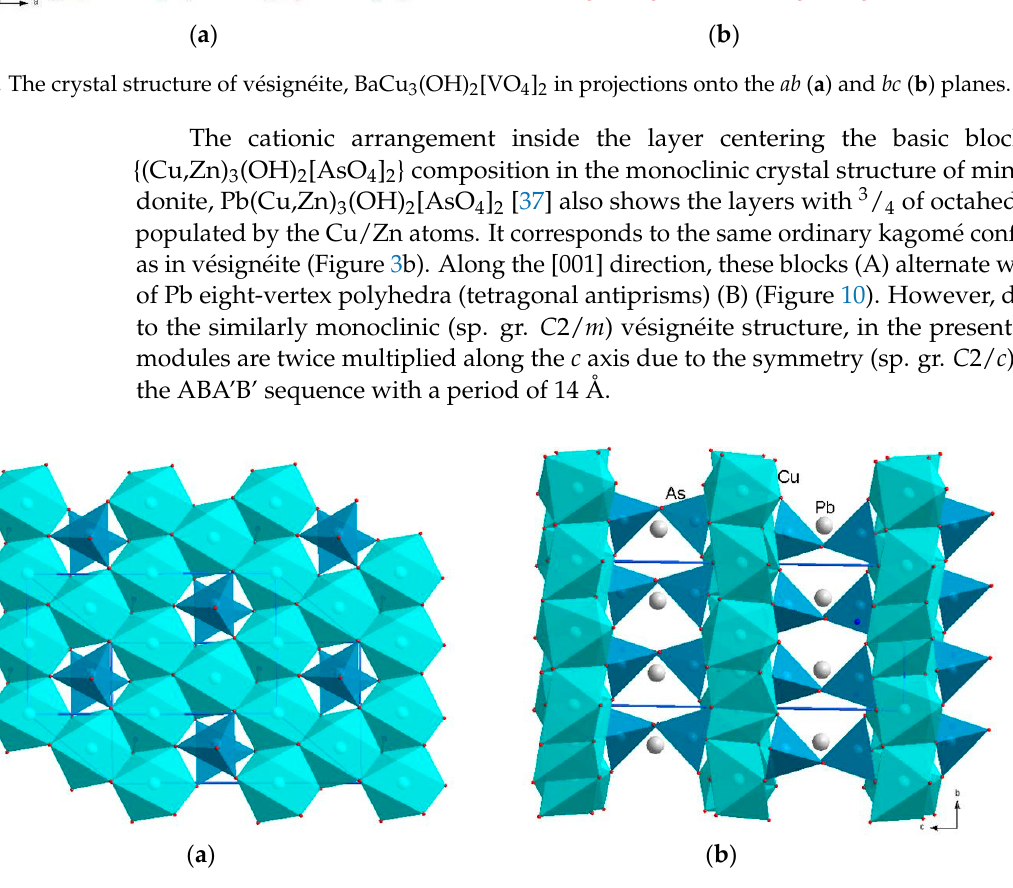
Figure 10. The crystal structure of bayldonite, Pb(Cu,Zn) 3 (OH) 2 [AsO 4 ] 2 projected onto the ab ( a ) and bc ( b ) planes.